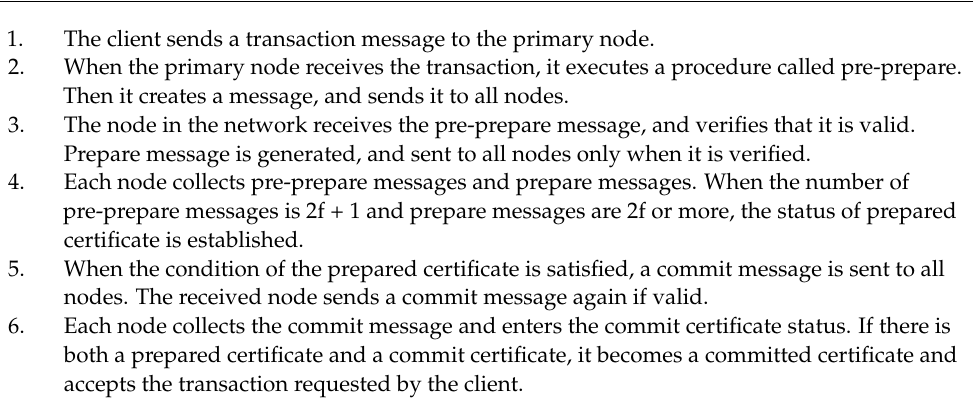
Algorithm 1. PBFT Algorithm (f = the number of Byzantine nodes)